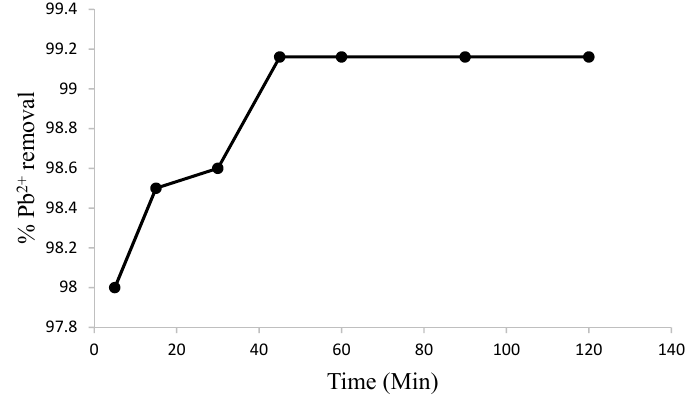
Figure 6. Variation of percent Pb 2+ ion removal with contact time (initial concentration = 10.7 mg/L, T = 298 K, pH = 4, shaking speed = 250 rpm, adsorbent dosage =1.0 g).